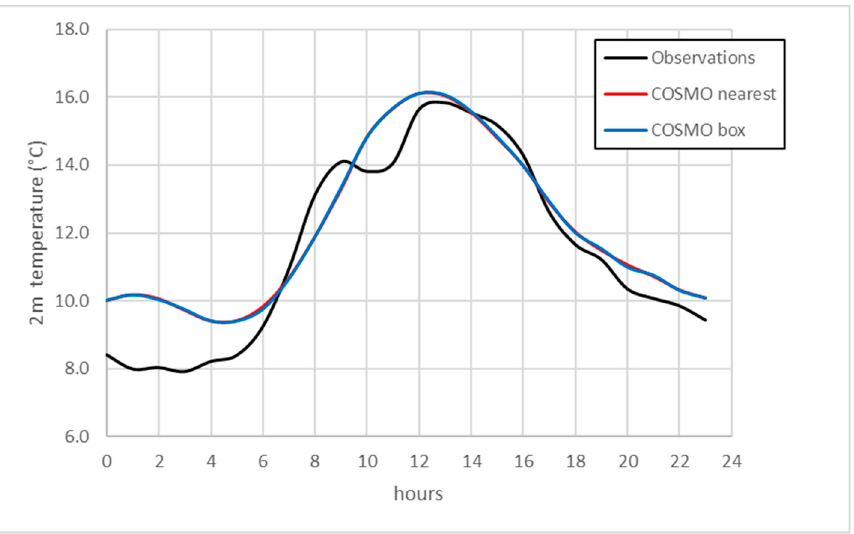
Figure 3. Diurnal cycle of t2m (°C) at the CIRA site averaged over the considered period: observa- tional and model data for the nearest grid point and grid box. Table 1. Mean, maximum positive and maximum negative temperature bias ( ◦ C) and RMSE ( ◦ C) of the model against observational data. Index of agreement d (non-dimensional). Both nearest point and grid box values are